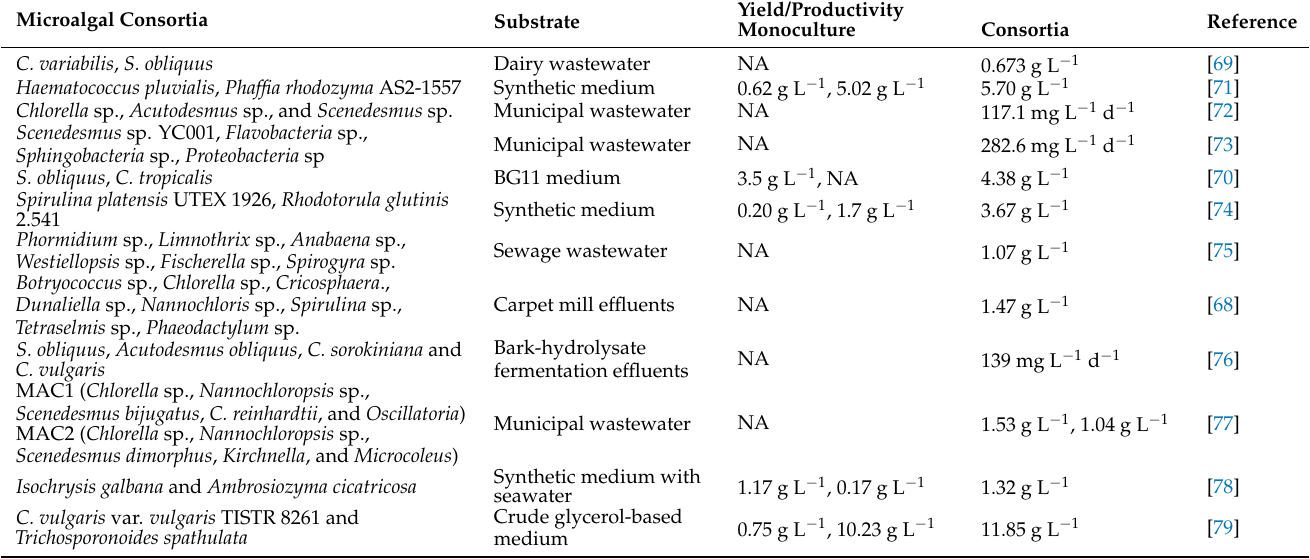
Table 3. The biomass production of microalgal